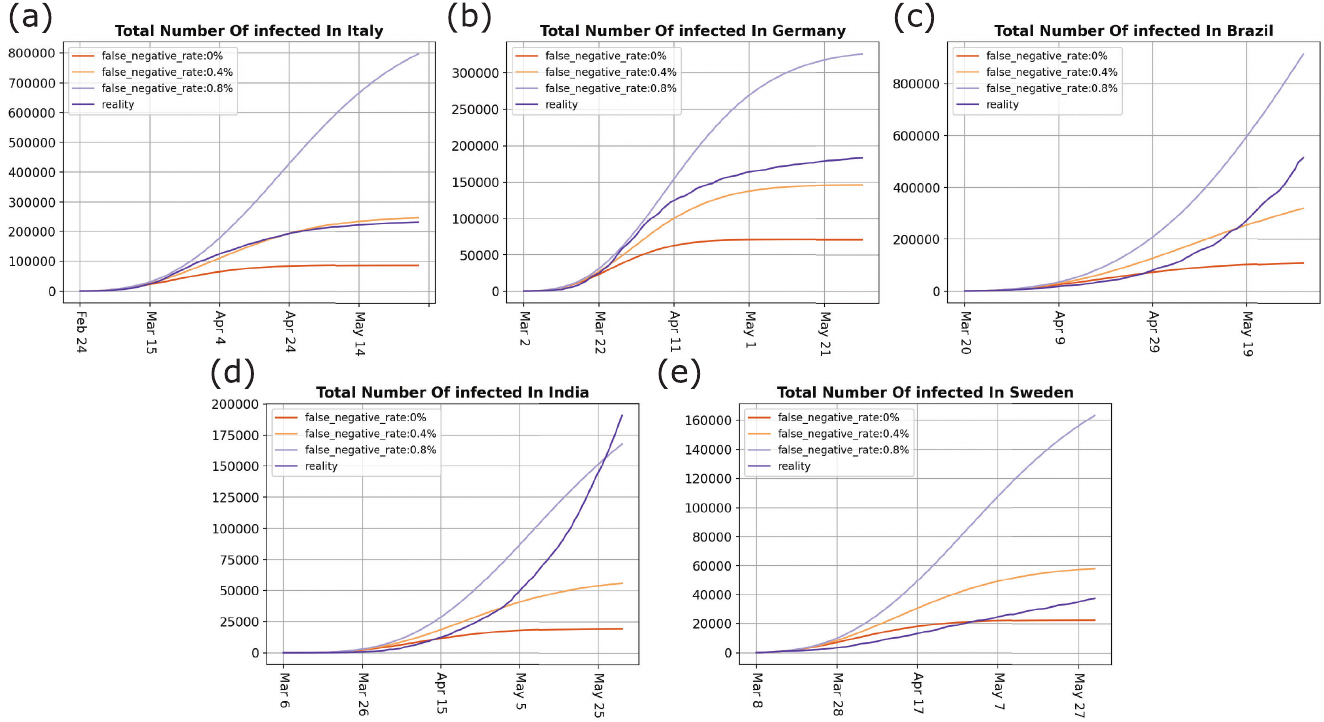
Fig 2. Total number of infected individuals. (a) total number of infected in Italy, (b) total number of infected in Germany, (c) total number of infected in Brazil, (d) total number of infected in India, and (e) total number of infected in Sweden. The red curve describes the total number of infected in the real world, and the other curves are the simulated total number of